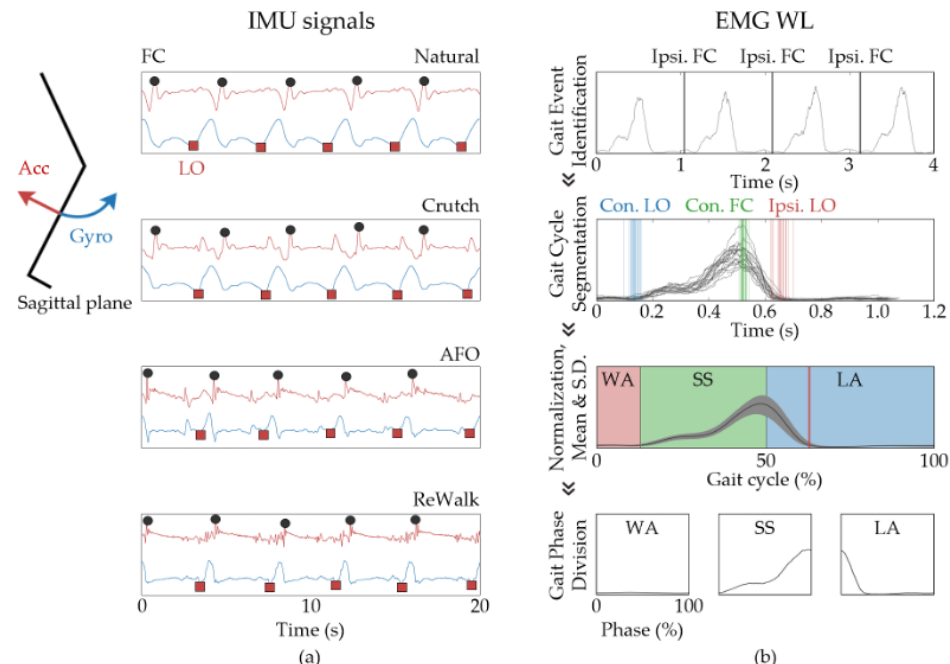
Figure 1. Signal processing and representation of data acquired during gait sessions. ( a ) Gait event detection via acceleration (red lines) and angular velocity (blue lines) obtained from IMU sensors placed on the shank. The IMU data obtained from the shank of subject 1 is shown for each gait condition. The points at which the foot makes initial contact and leaves the ground are marked with black circles and red squares, respectively. ( b ) The top panel shows the EMG WL of soleus muscle during three gait cycles. Using the ipsilateral FC position (black lines), the SL EMG WL can be segmented into gait cycles (second panel). The blue, green, and red lines depict contralateral limb LO, contralateral limb FC, and ipsilateral limb LO, respectively. The third panel shows the ensemble-mean and SD of the SL EMG WL within a gait cycle with a black line and grey area, respectively. In addition, the red, green, and blue stages depict the WA, SS, and LA phases, respectively. The bottom panel depicts the mean SL EMG WL normalized against the respective phase progression.